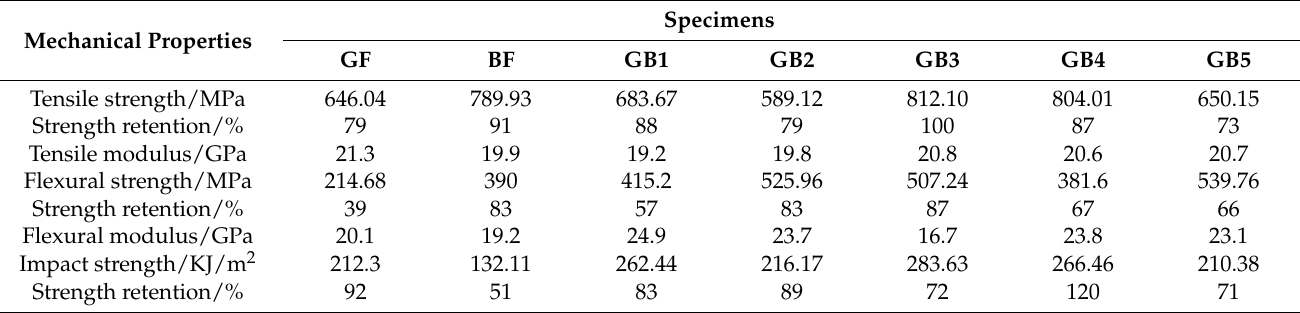
Table 4. Mechanical properties of plain and hybrid specimen after seawater